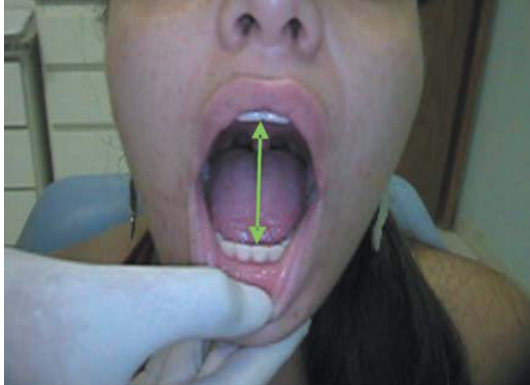
FIGURE 4- Mandibular range of motion two years after